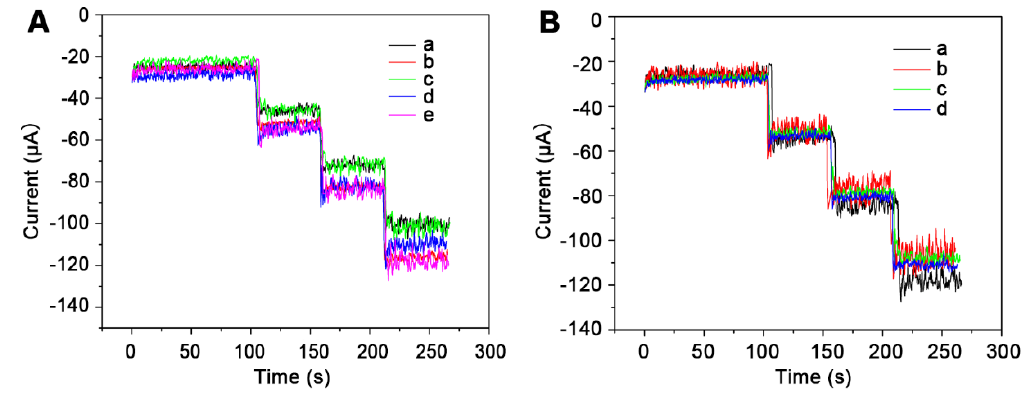
Figure 6. Results obtained using the H 2 O 2 sensor are highly sensitive and reproducible. ( A ) The i-t curves of MoS 2 -Au-Ag / GCE were dripped with the same concentration of H 2 O 2 into PBS. ( B ) The i-t curves of the same MoS 2 -Au-Ag / GCE when the same concentration of H 2 O 2 was dripped into PBS after the electrode was placed at different times.